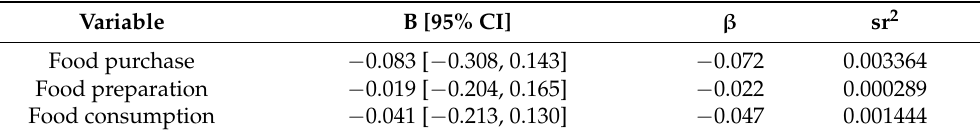
Table 4. Unstandardised (B) and standardised ( β ) regression coefficients and squared semi-partial correlations (sr 2 ) for each predictor in a regression model predicting oral health